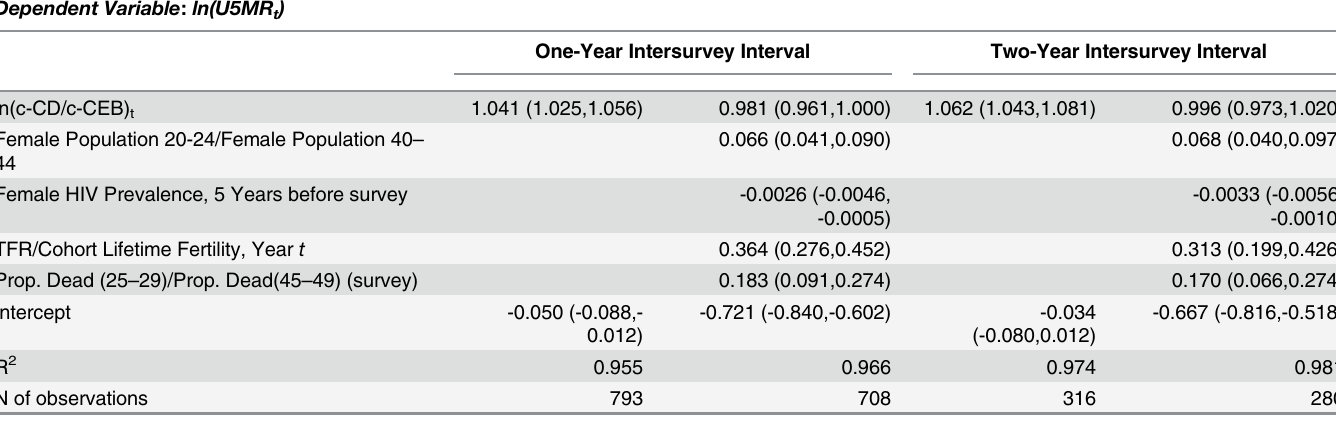
Table 1. Regression Coefficients for Relationship between Ratios of Cumulated Cohort Changes in CD to CEB and U5MR in